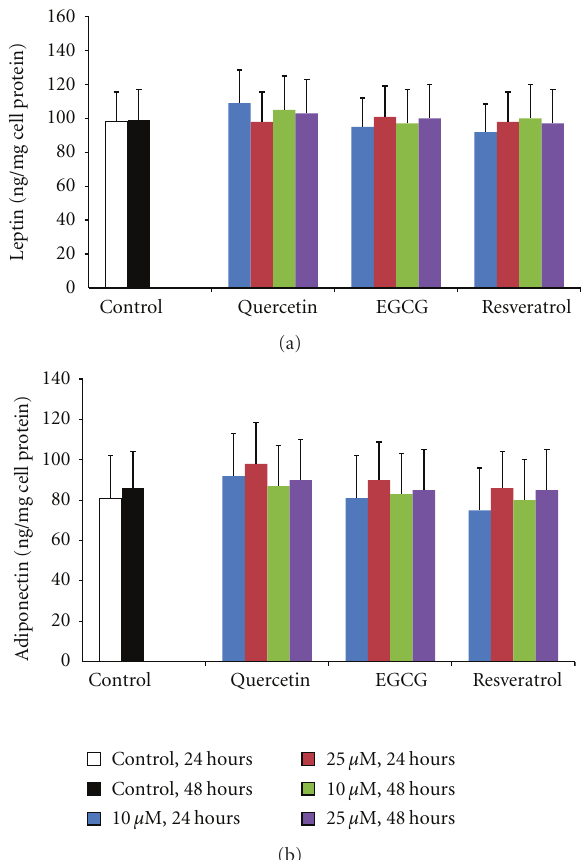
Figure 1: Polyphenols quercetin, epigallocatechin gallate (EGCG), and resveratrol do not a ff ect leptin (a) and adiponectin (b) secretion by human mature SGBS adipocytes. Cells were cultured in medium and incubated with 10 or 25 μ M of quercetin, EGCG, and resvera- trol for 24 and 48 hours. Leptin and adiponectin were determined in the cell supernatant by commercially available methods. Values represent the mean ± SD.